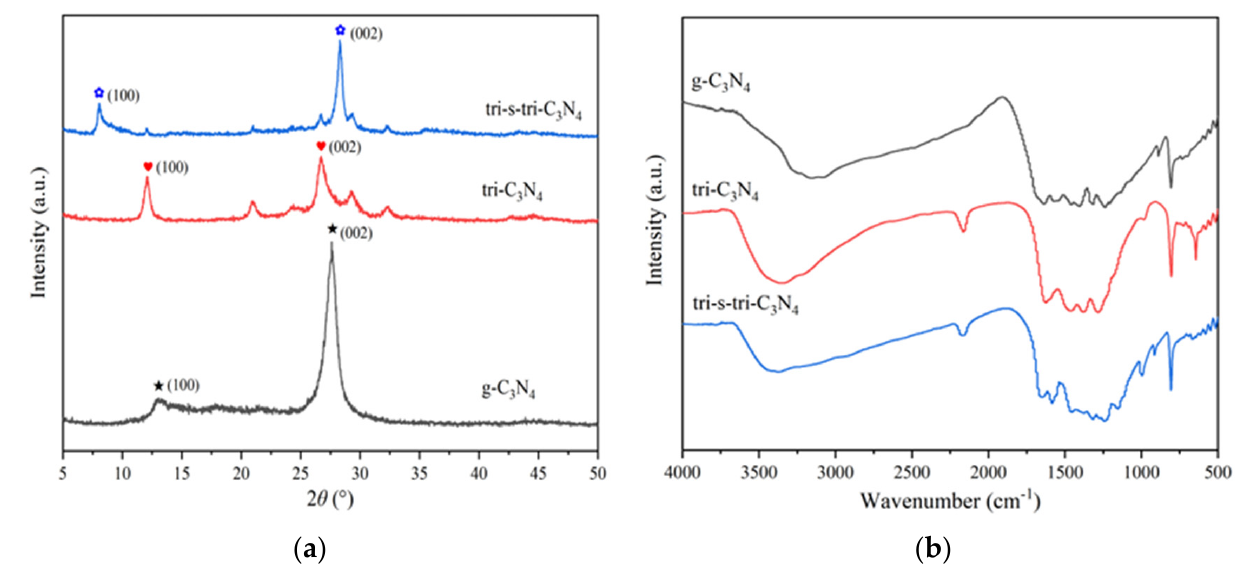
Figure 2. XRD pattern ( a ) and FT-IR spectra ( b ) of g-C 3 N 4 , tri-C 3 N 4 , and tri-s-tri-C 3 N 4 . The microscopic morphology of g-C 3 N 4 , tri-C 3 N 4 , and tri-s-tri-C 3 N 4 was observed